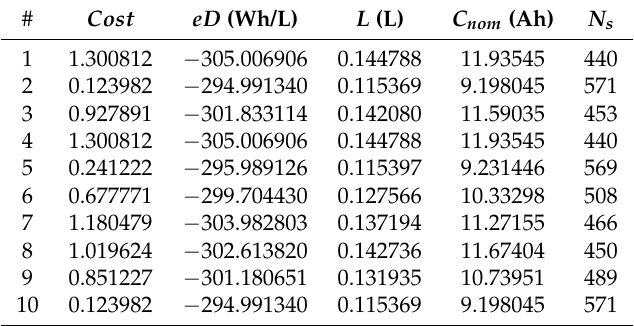
Table 3. Optimal solution set.